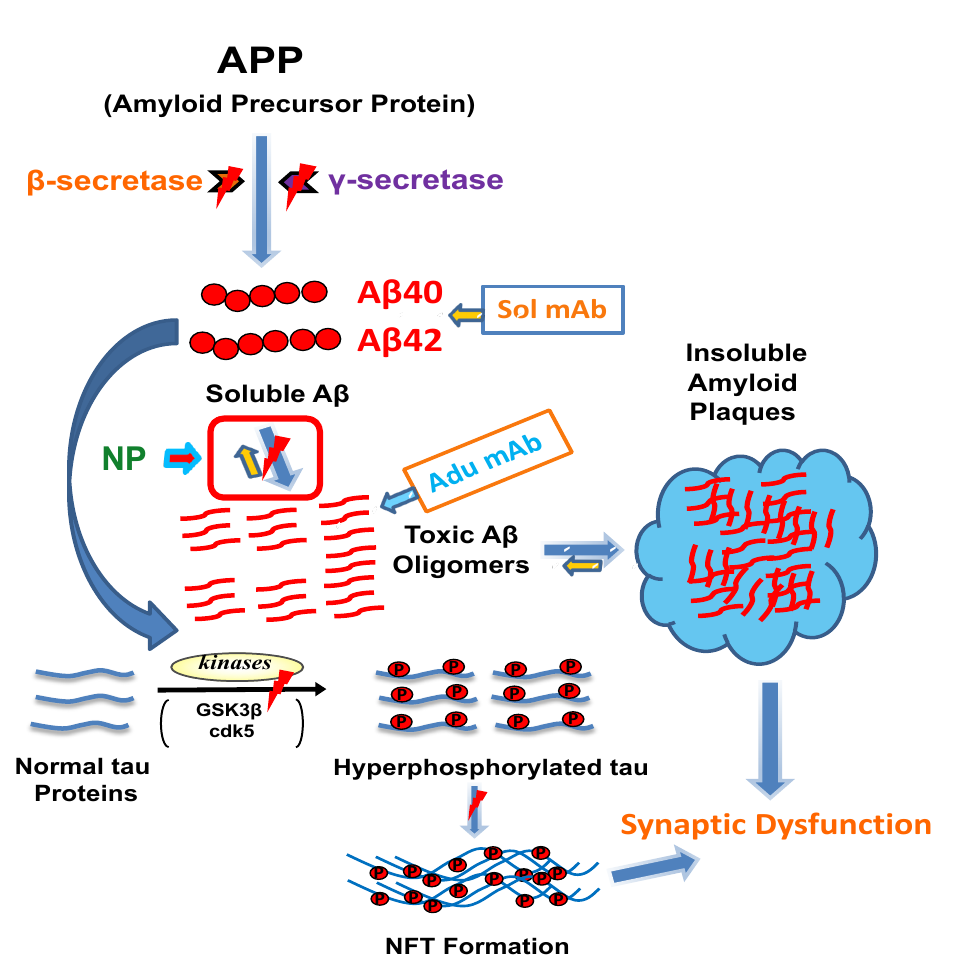
Figure 1: Alzheimer’s prominent mechanisms and interventions ( ⚡ ) of most disease-modifying therapies for AD. NP: Natural Product; Solanezumab (Sol mAb) and Aducanumab (Adu mAb) are immunotherapies targeting soluble monomeric Aβ and soluble Aβ aggregates and insoluble fibrils,